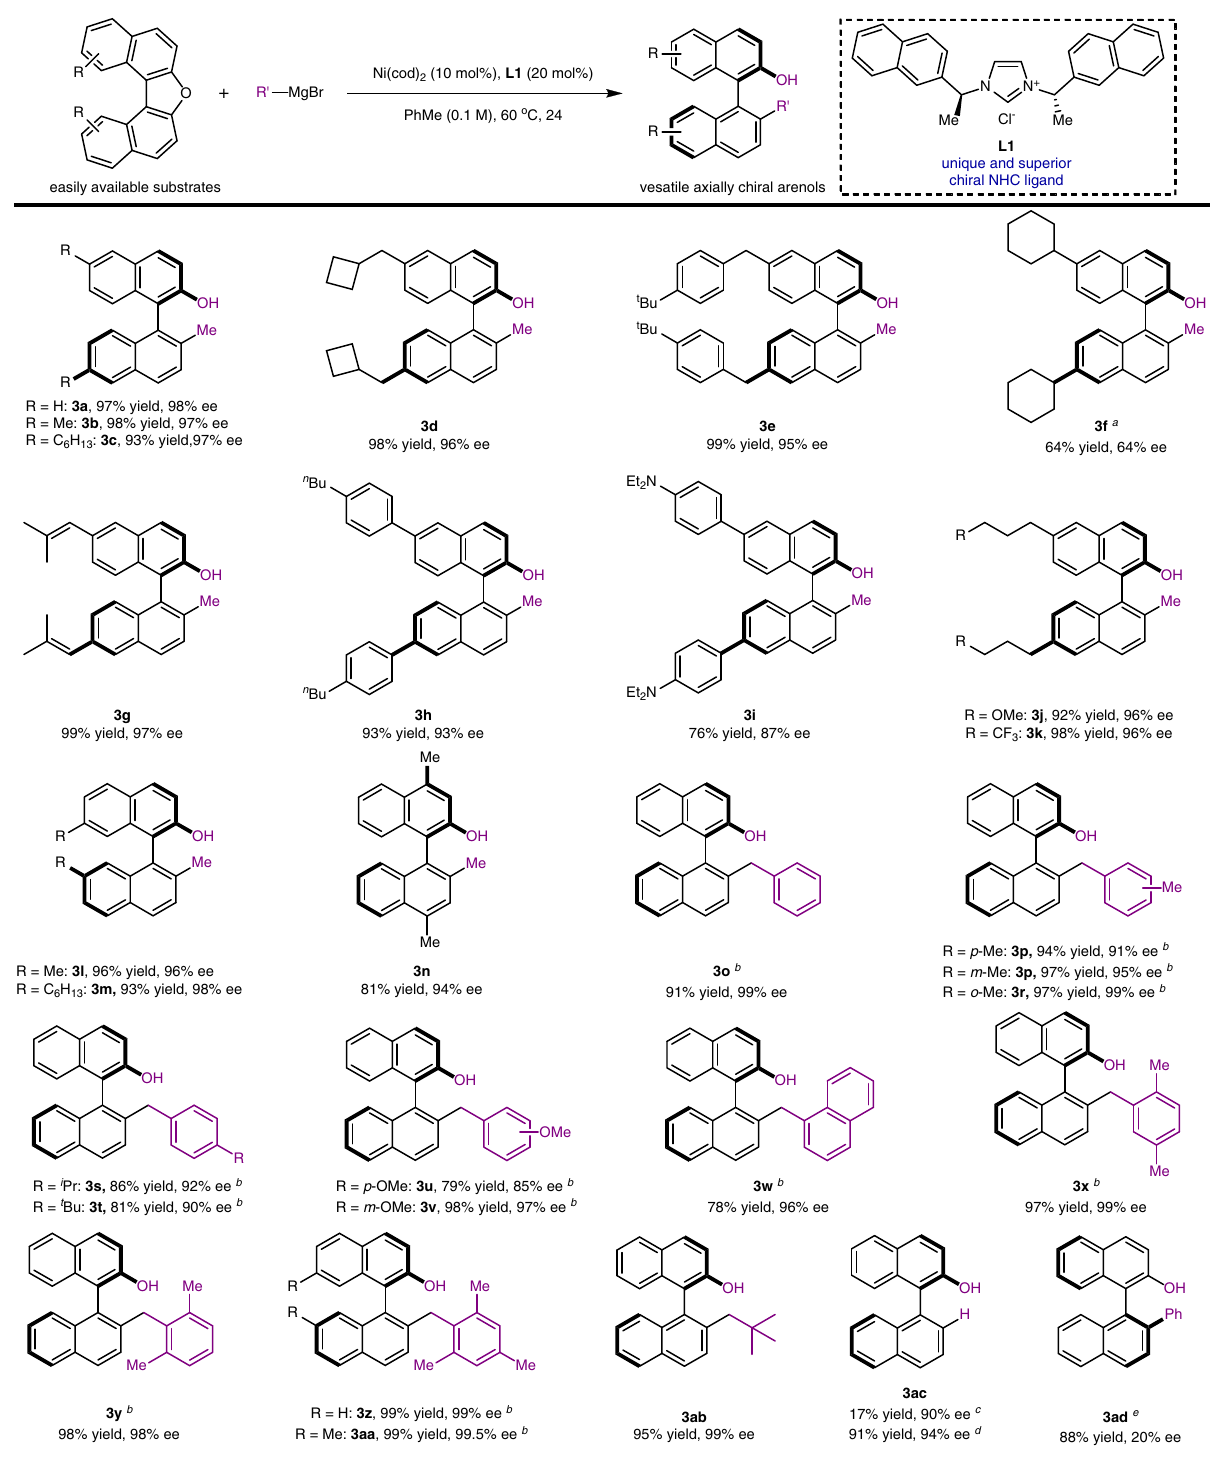
Fig. 2 Substrate scope of the enantioselective alkylative cross-coupling of unactivated C – O bond. Unless otherwise stated, the reactions were carried out by using C – O electrophiles (0.2 mmol), R ′ – MgBr (3.0 equiv.), Ni(cod) 2 (10 mol%), L1 (20 mol%) in PhMe (0.1 M) at 60 °C for 24 h; a The reaction was conducted at 80 °C; b R ′ – MgCl (3.0 equiv.) were used and reactions were conducted at 60 °C for 36 h; c Ethyl magnesium bromide (Et – MgBr) (3.0 equiv.) was used; d Cyclo-hexyl magnesium bromide (C 6 H 11 – MgBr) (3.0 equiv.) was used; e Phenylmagnesium chloride (Ph – MgCl) (3.0 equiv.) was with high ee. To elucidate the role of ligand L1 in this enantio- nickel ’ s ligation state in the enantioselective alkylative cross- selective alkylative cross-coupling, we set out to explore the coupling of aromatic C – O electrophiles. By using 5 mol% reaction mechanism. Given the dramatic in fl uence of ligation Ni(cod) 2 as the nickel source, the enantioselective methylative state of nickel in transition-metal catalyzed aromatic C – O activation of substrate 1a were performed in the presence of activation 63 – 66 , control experiments were conducted to identify different amount of chiral ligand L1 , and found that only 76%